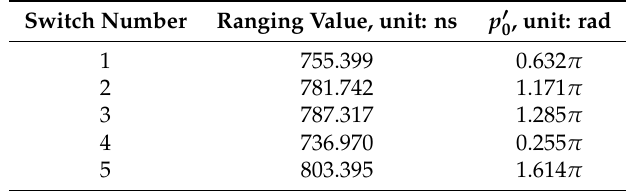
Table 2. Collected actual power switch ranging data without the phase compensation sensor.